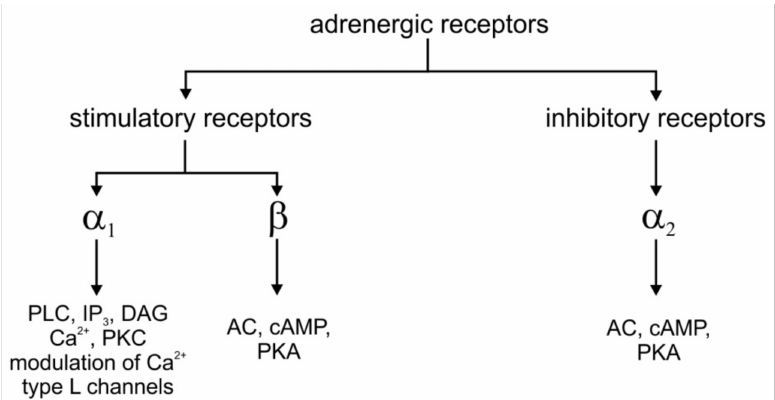
Figure 1. Classification of adrenergic receptors [56–58]. cAMP—3’,5’-cyclic adenosine monophos- phate, DAG—diacylglycerol, IP3–inositol 1,4,5-trisphosphate, PKA—protein kinase A, PKC—protein kinase C, PLC—phospholipase